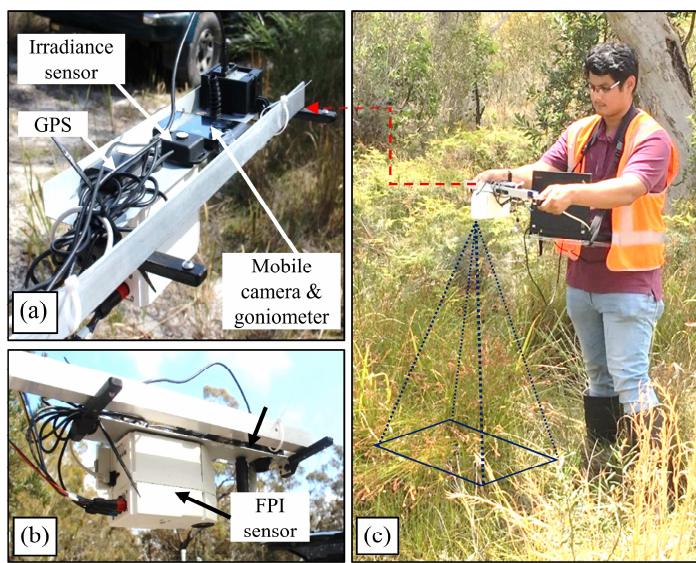
Figure 1. The setup for ground-based hyperspectral data acquisition using a Fabry–Pérot interfer- ometer (FPI) sensor (Rikola, Senop Optronics, Kangasala, Finland), an irradiance sensor, a global position system (GPS), and an android phone as goniometer on a portable handheld sensor mount: ( a ) top-side view, ( b ) bottom-side view, and ( c ) in-field hyperspectral data acquisition with a